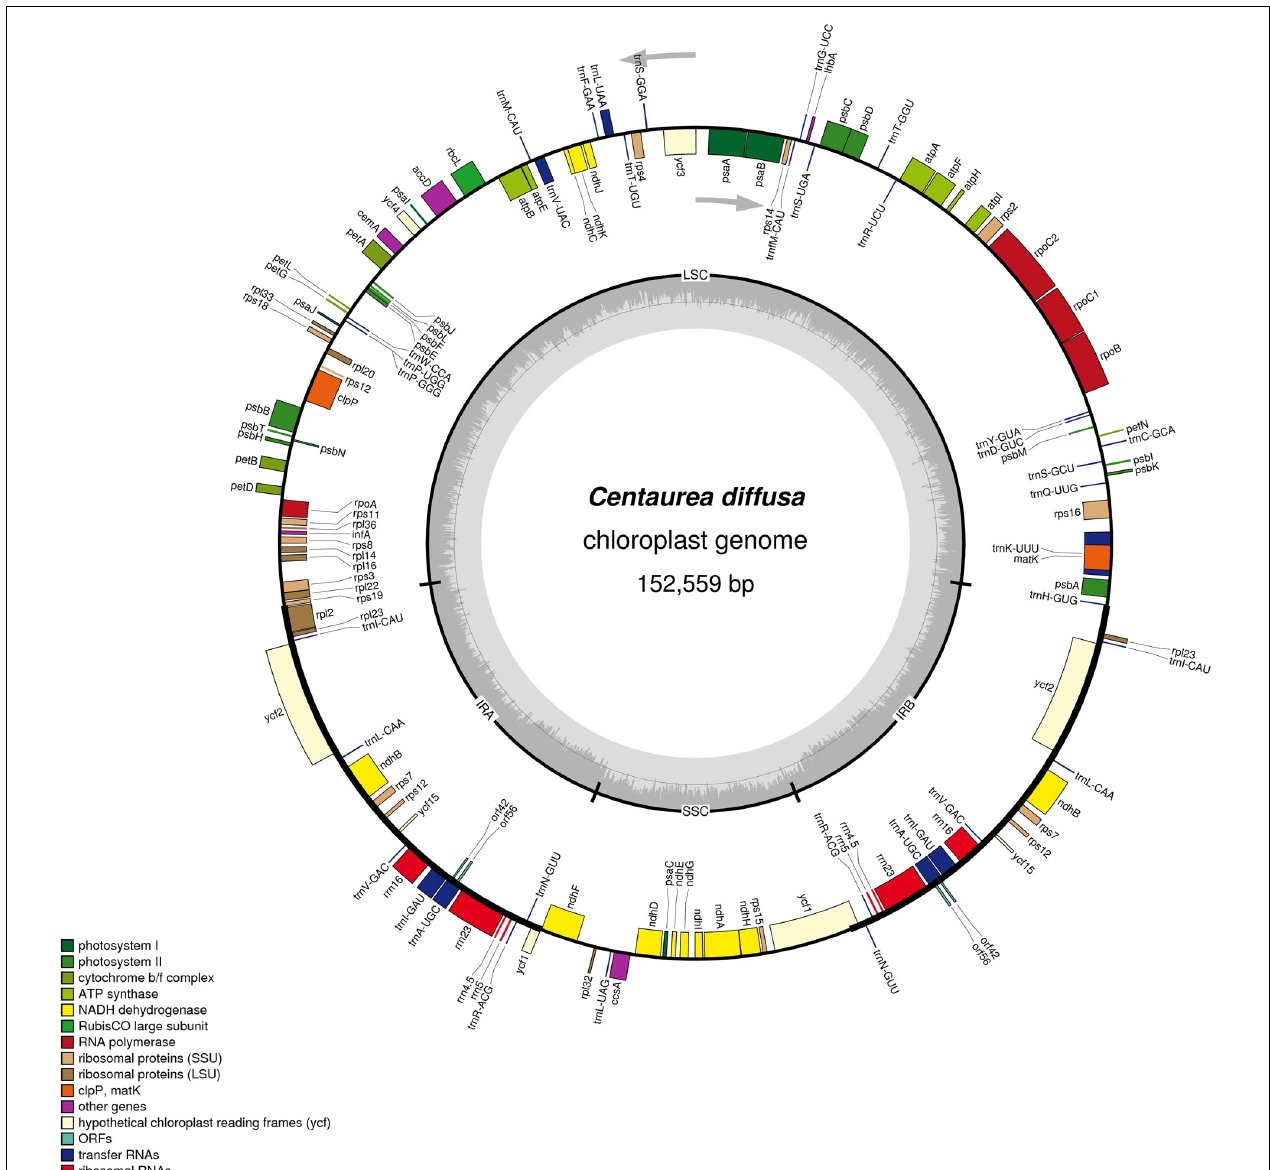
FIGURE 2 | Annotated plastome of Centaurea diffusa . Map of complete annotated C. diffusa